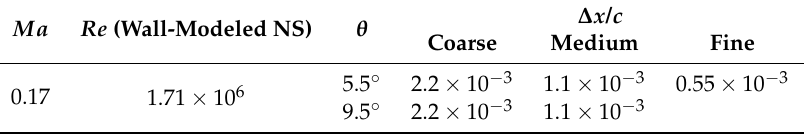
Table 3. Simulation conditions for the flow around a 30P30N high-lift airfoil